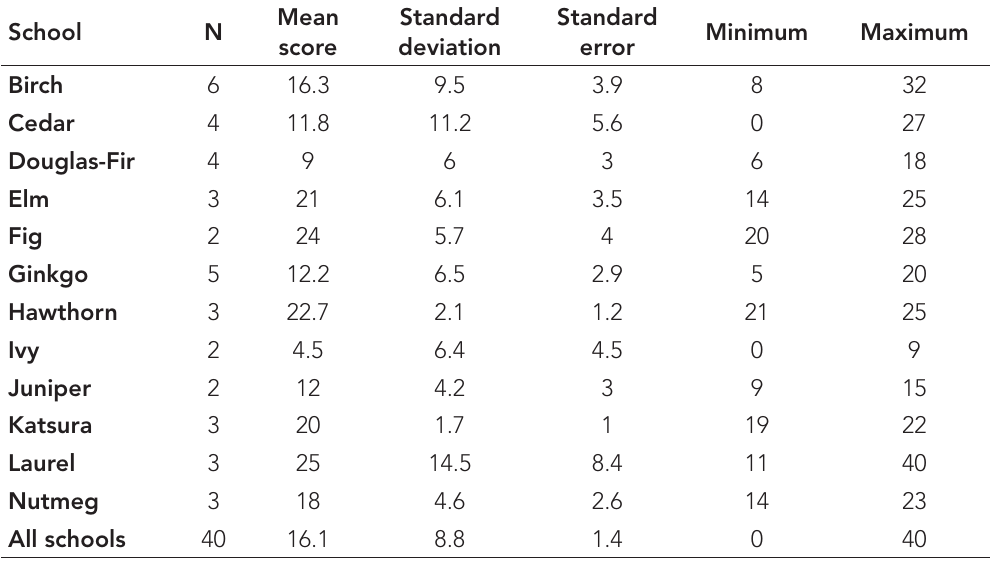
Table 4: Descriptive statistics for combined scores of participation in activities characteristic of effective PL by